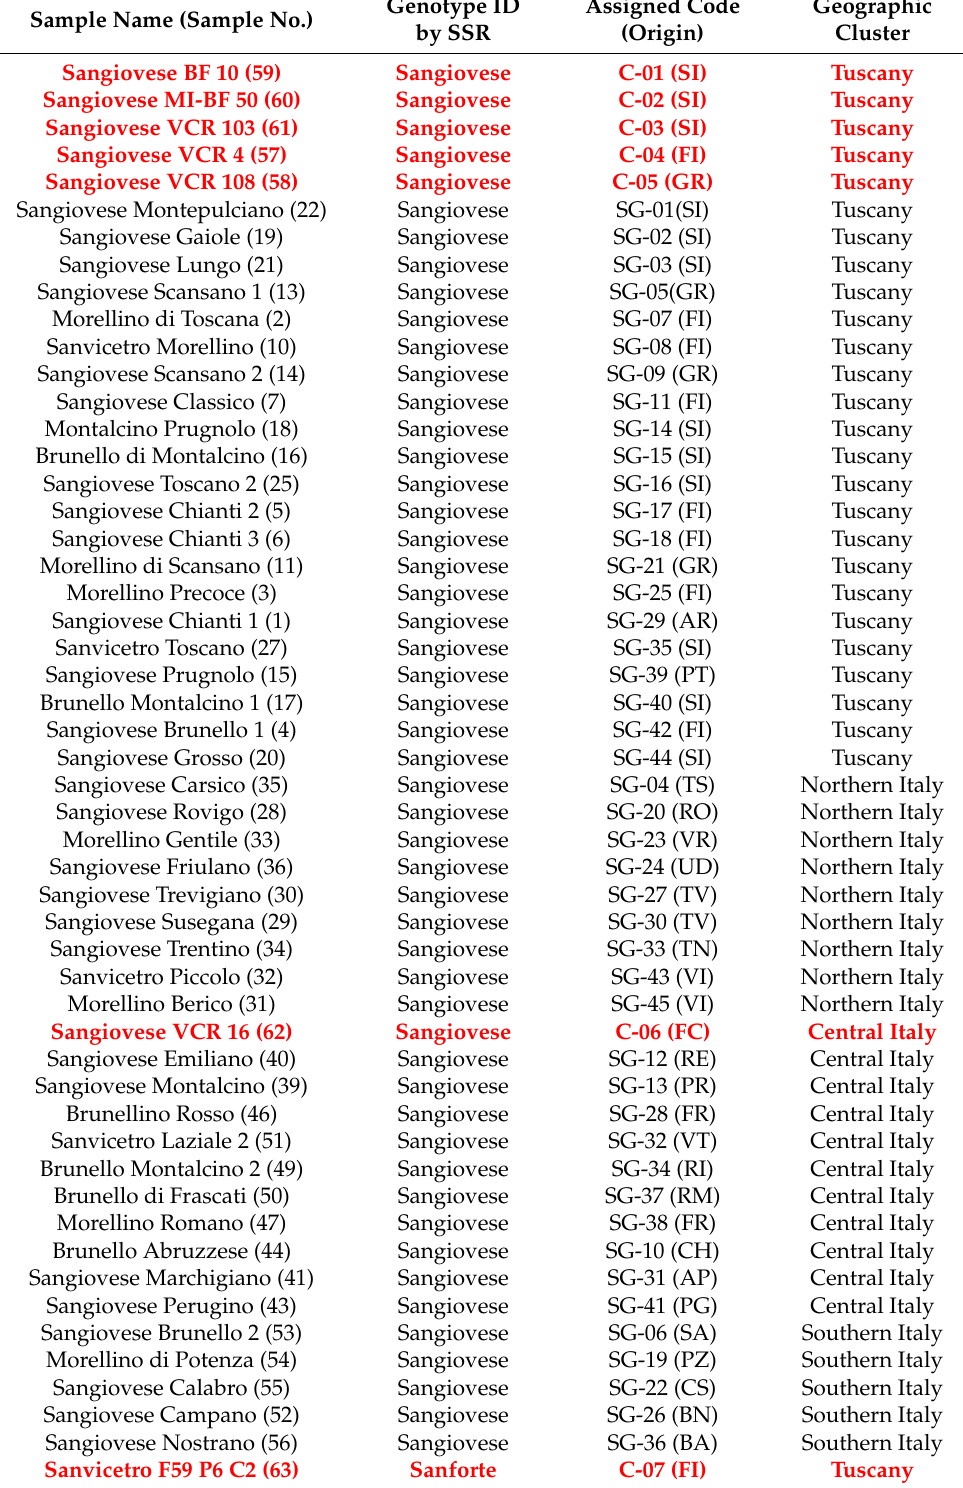
Table 3. Varietal identification by SSR markers of the 78 samples analyzed and geographic cluster set using AFLP, SAMPL, M-AFLP, and I-SSR molecular markers. The assigned code is composed of the initial letters of the variety progressive number (origin: provincial acronym). The 7 reference clones and 1 reference biotype are highlighted in bold